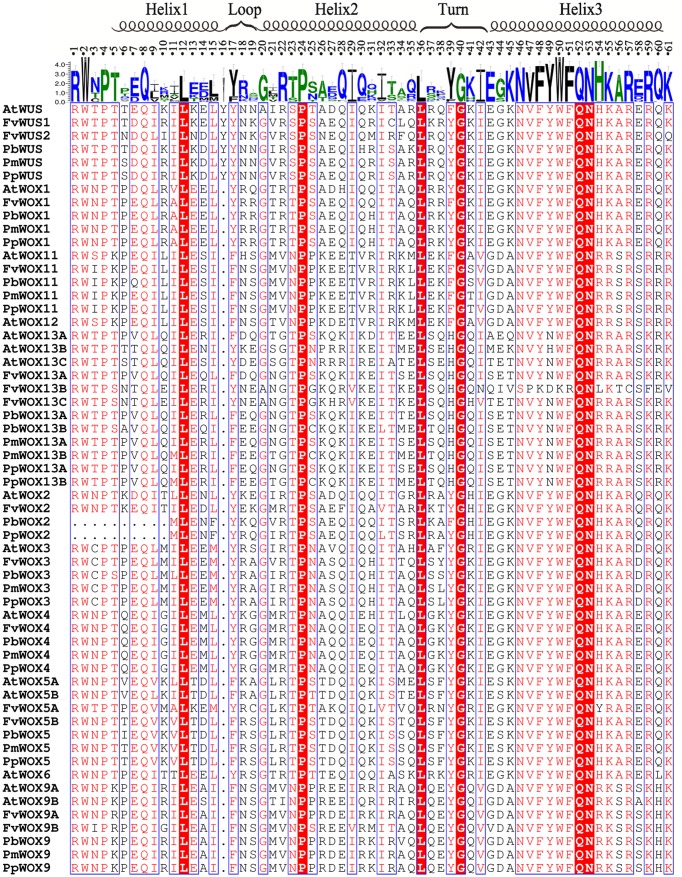
Alignment of the WOX homodomain sequences in five plant species. Highly conserved residues of homodomains were represented by the red shaded blocks in the five tested species. The secondary structure was indicated according to Mayer et al. (1998).